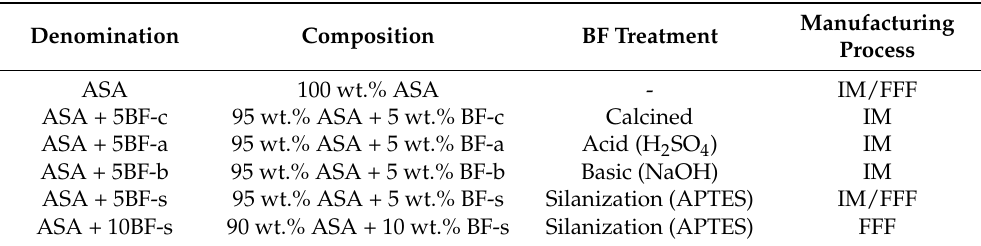
Table 2. Summary of all the composites with denomination, composition and manufacturing pro- cesses used in this